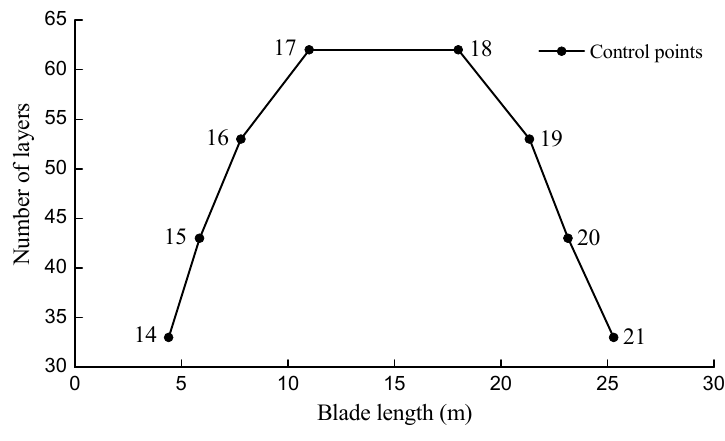
Figure 10. Parametric material layup of the spar cap.